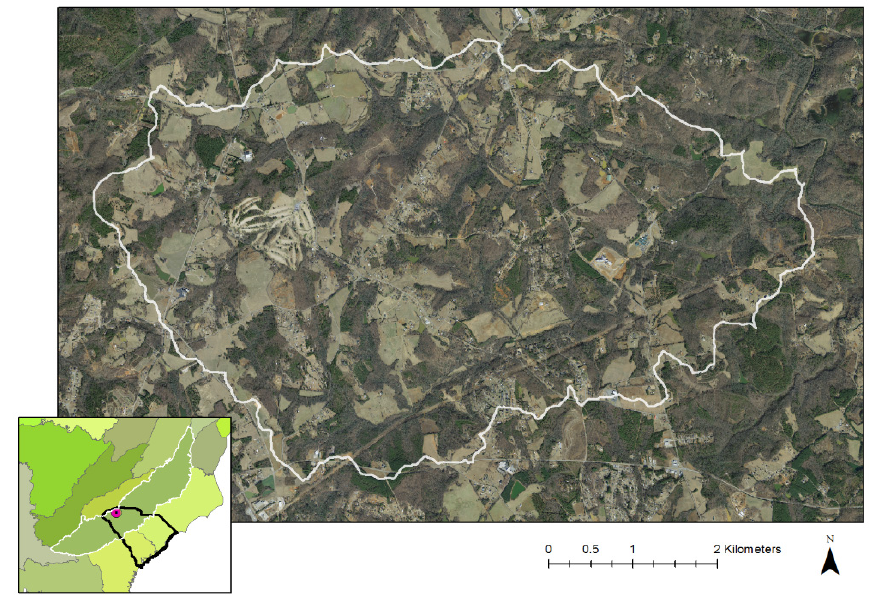
Figure 2. Aerial image from 2011 of the 29.7 km 2 Doddies Creek watershed. Inset: The watershed (purple dot) is located within the Piedmont ecoregion (white border) in South Carolina (black border), USA. Table 1. Summary of percent land cover and total and aboveground estimates of NPP act for 12 identified land cover classes in Doddies Creek watershed for 1968 and